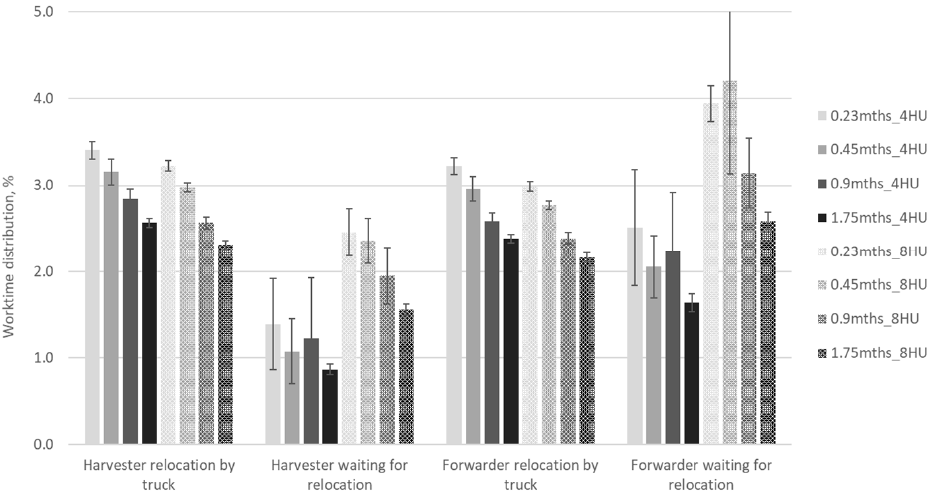
Figure 10. The shares of machine relocation and waiting for the relocation with harvester and forwarder of the total working time when the average harvesting site reserve in months (mths) varied for scenario runs of 4 and 8 HU. Shown are 95% CI error bars for 7 replications.